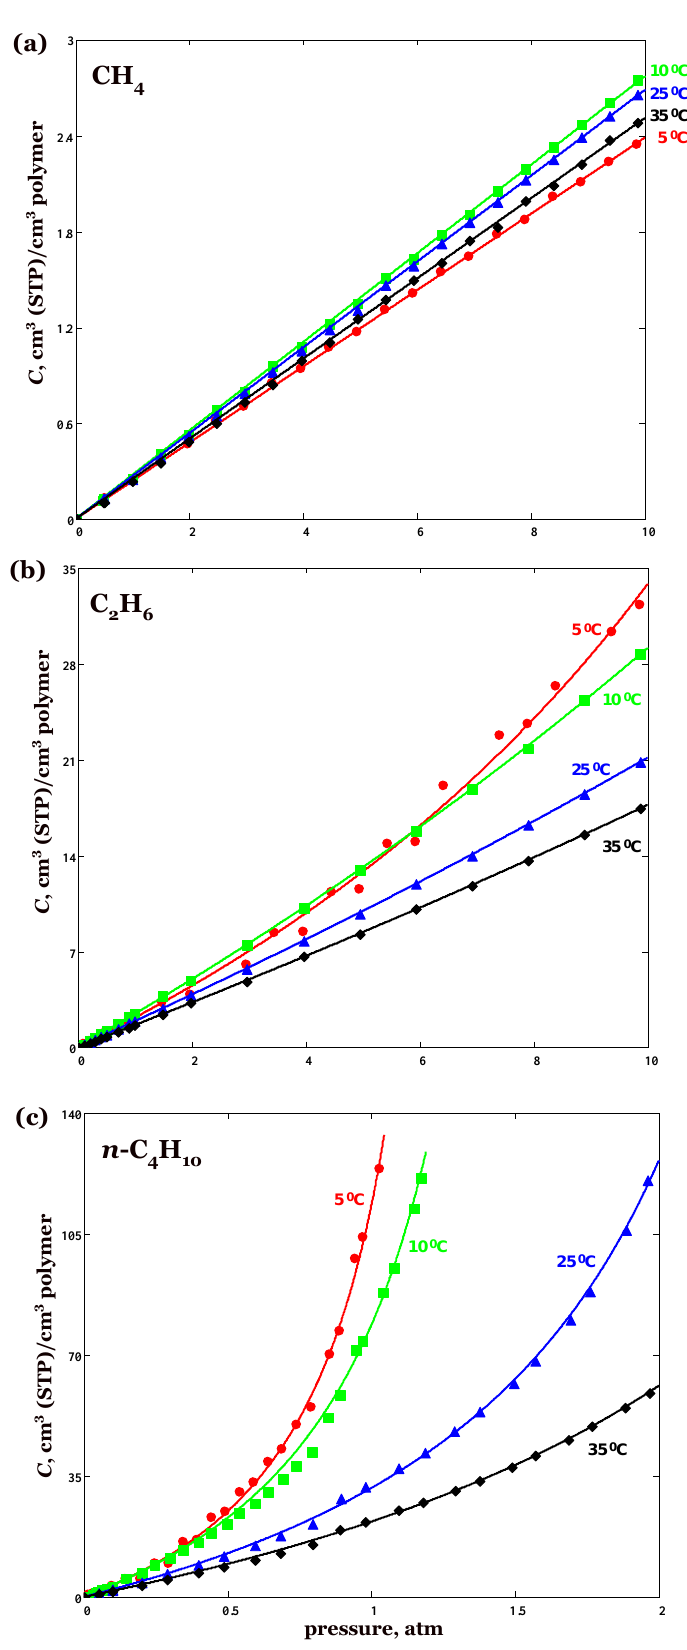
Figure 1. Methane ( a ), ethane ( b ), and butane ( c ) sorption isotherms in PTDMS silicone rubber at the temperature range 5 – 35 °C. Points — experimental data, lines — approximation of the experimental data by Equation (8); in the case of methane the linear function of gas pressure was used.